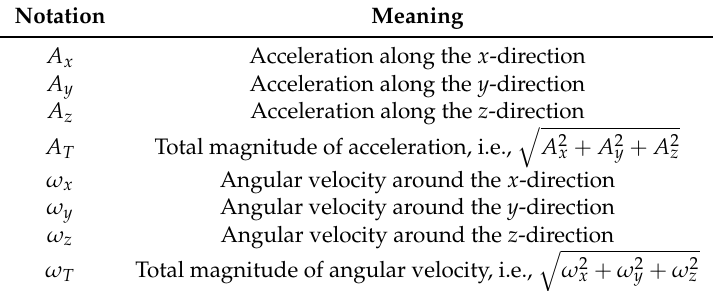
Table 1. Each unit’s data